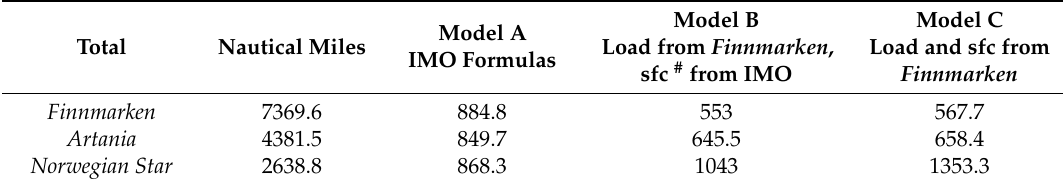
Table 14. Estimates for total fuel consumption for Finnmarken , Artania , and Norwegian Star with different